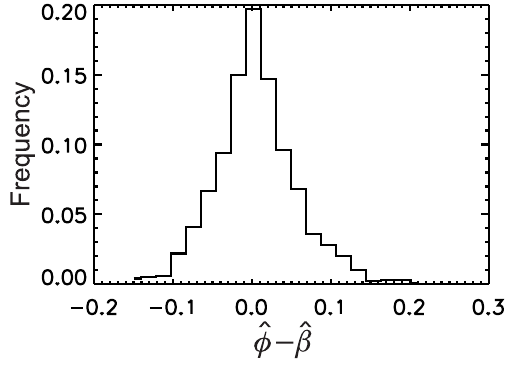
Fig. 8. Histogram of φ − β .